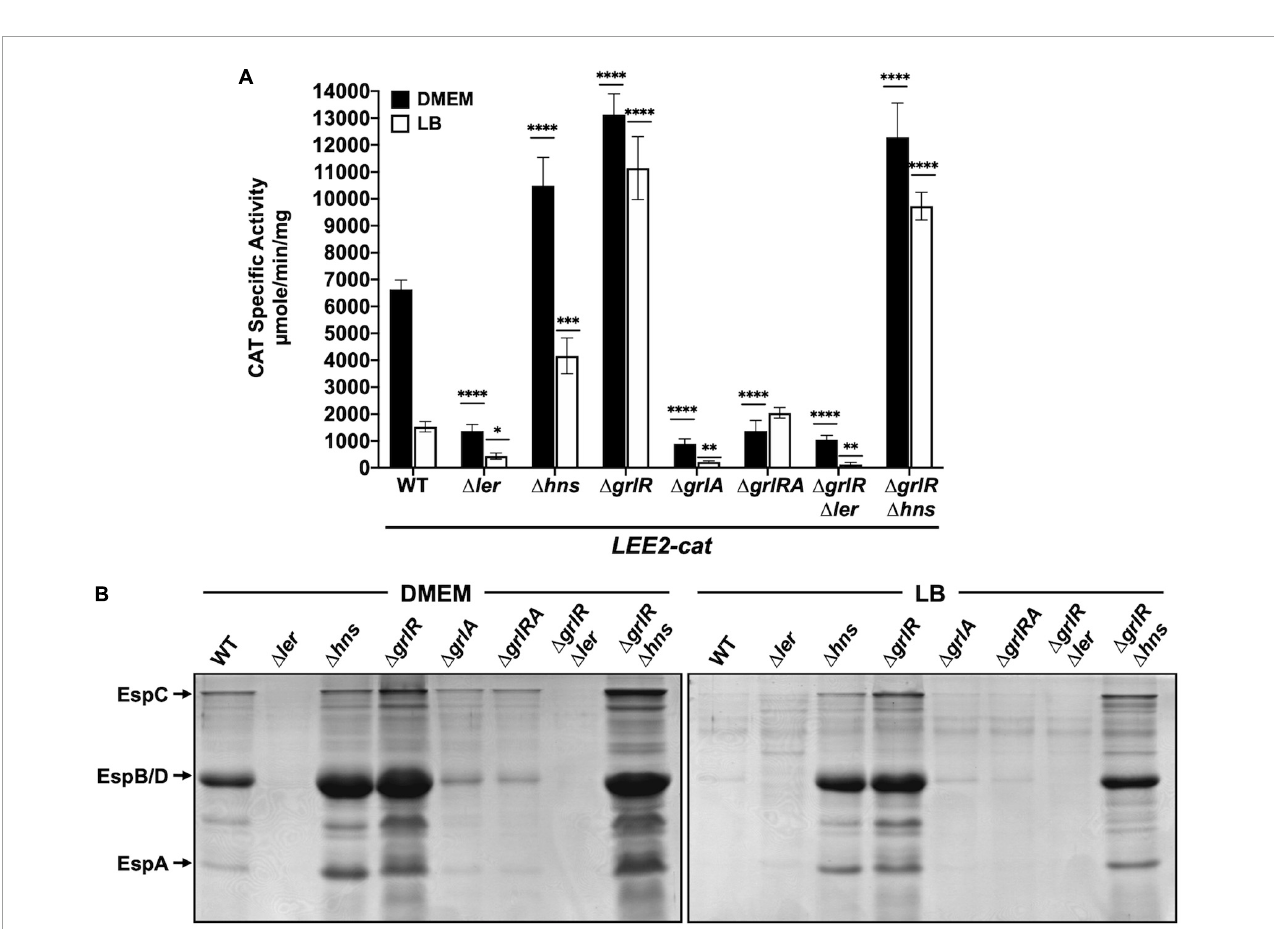
FIGURE4 GrlR and H-NS repress locus of enterocyte effacement (LEE) gene expression by an indirect cooperative mechanism. (A) chloramphenicol acetyltransferase (CAT) activity of the LEE2-cat fusion was determined in WT enteropathogenic Escherichia coli (EPEC) and its (cid:49) ler , (cid:49) hns , (cid:49) grlR , (cid:49) grlA , (cid:49) grlRA , (cid:49) grlR (cid:49) ler , and (cid:49) grlR (cid:49) hns derivative mutants grown in 50 ml of Dulbecco’s modified Eagle’s medium (DMEM) (black bars) or Lysogeny Broth (LB) (white bars) with shaking at 37 ◦ C. Specific CAT activity was determined from samples collected at an OD 600 of 1. Values are an average of three independent experiments performed in duplicate. Error bars indicate standard deviations. Statistically different values are indicated ( ∗ p -value < 0.1; ∗∗ p -value < 0.01; ∗∗∗ p -value < 0.001; ∗∗∗∗ p -value < 0.0001). (B) Secreted proteins of the same cultures were concentrated from supernatants by precipitation with TCA, separated by 12% SDS-PAGE and stained with Coomassie brilliant